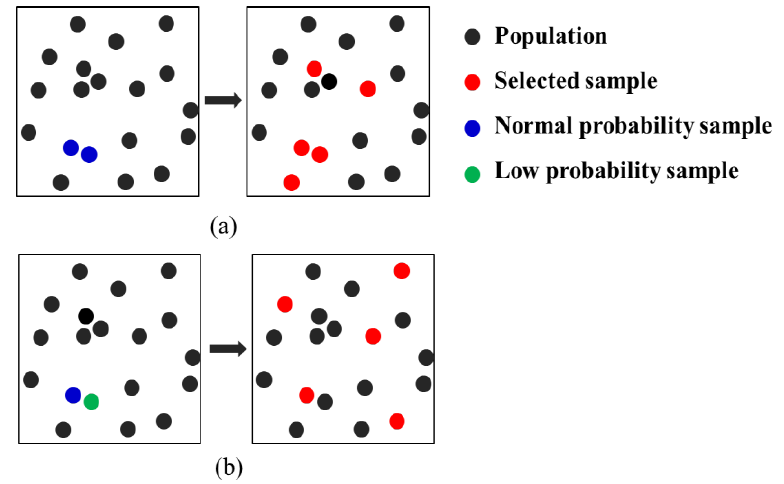
Figure 4. Comparison between SRS and LPM. ( a ) SRS. ( b ) LPM. The criteria for updating the inclusion probability are as follows.